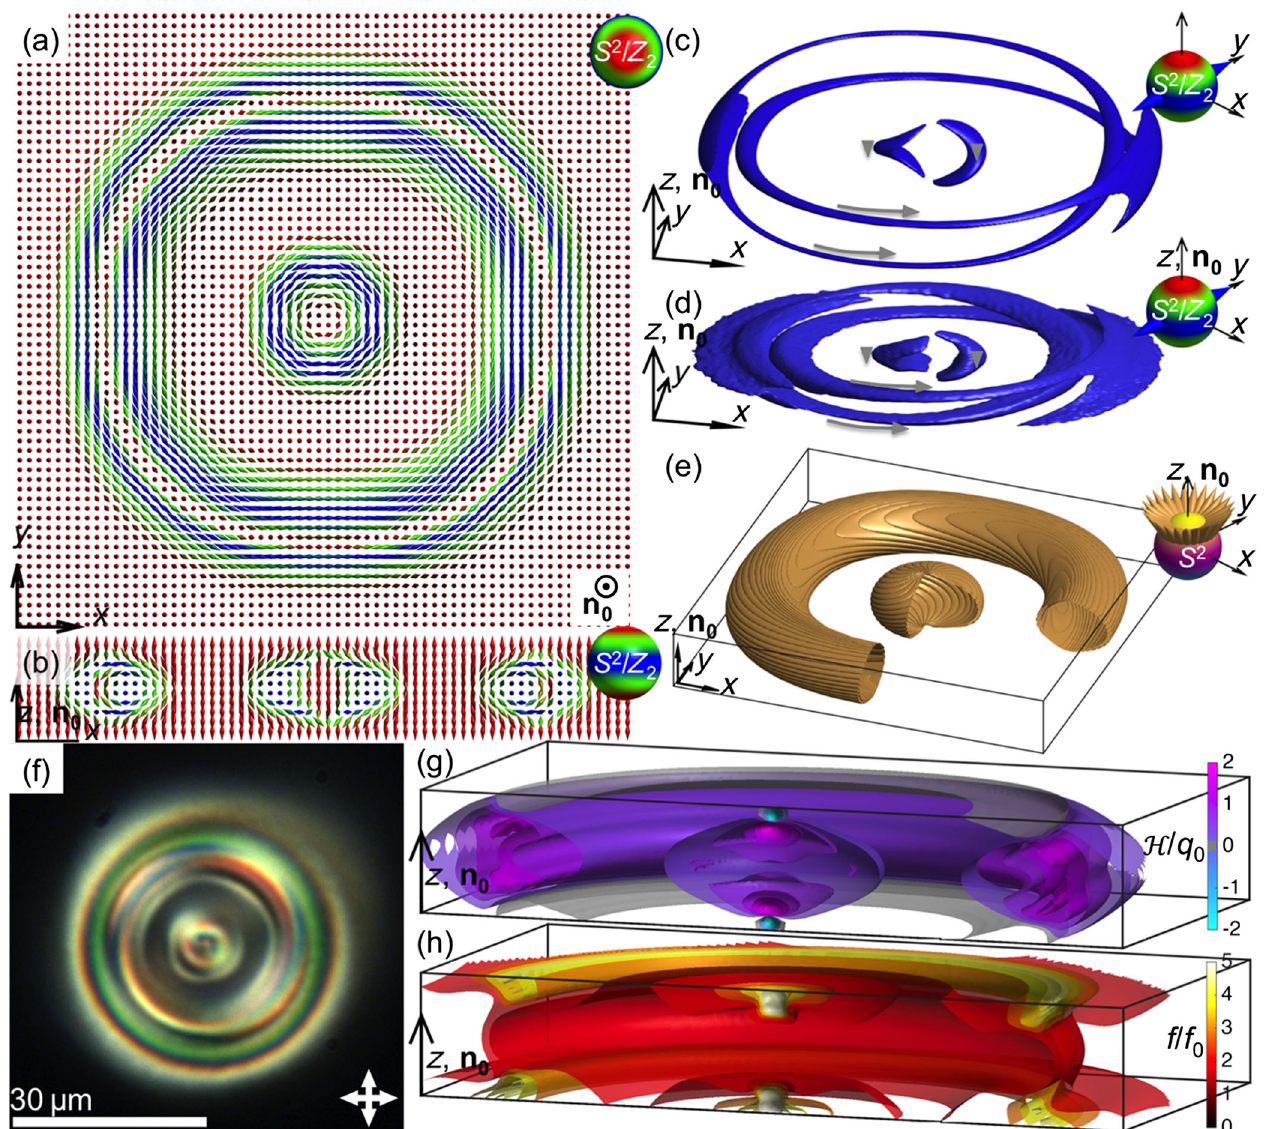
FIG. 10. 3D toron-hopfion hybrid solitons formed by coaxial arrangement of an elementary toron and elementary hopfion of Q ¼ 1 . (a), (b)Computer-simulated(a) in-planeorthogonalto n 0 and (b) vertical containing n 0 crosssections ofthe axially symmetric n ð r Þ